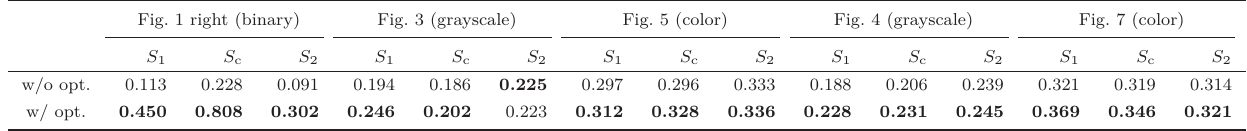
MSSIM for original input shares and output shares with and without optimization. We applied Gaussian bluring with a kernel size of 5 × 5 to the output images and compared them to the source images Fig. 1 right